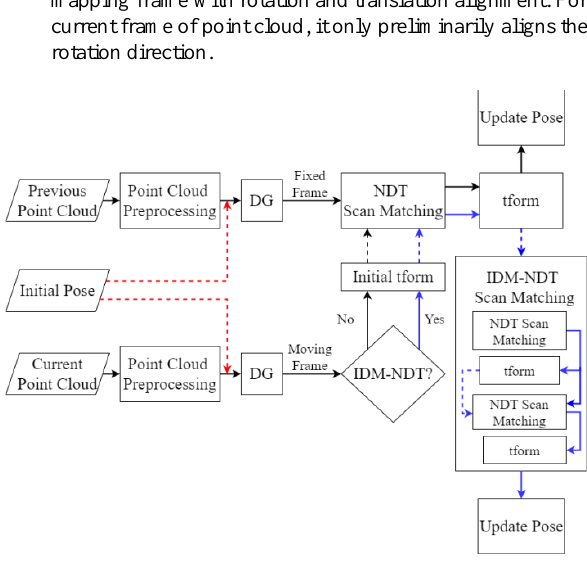
Figure 3 . NDT scan matching